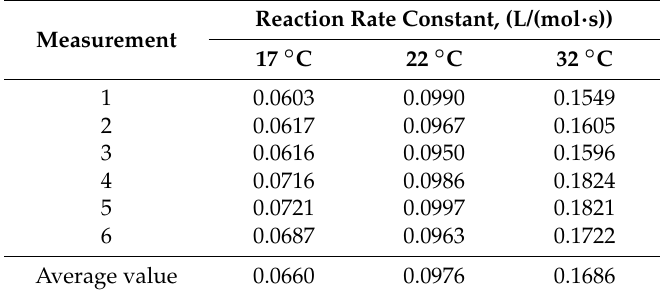
Table 3. Reaction rate constants at different temperatures.